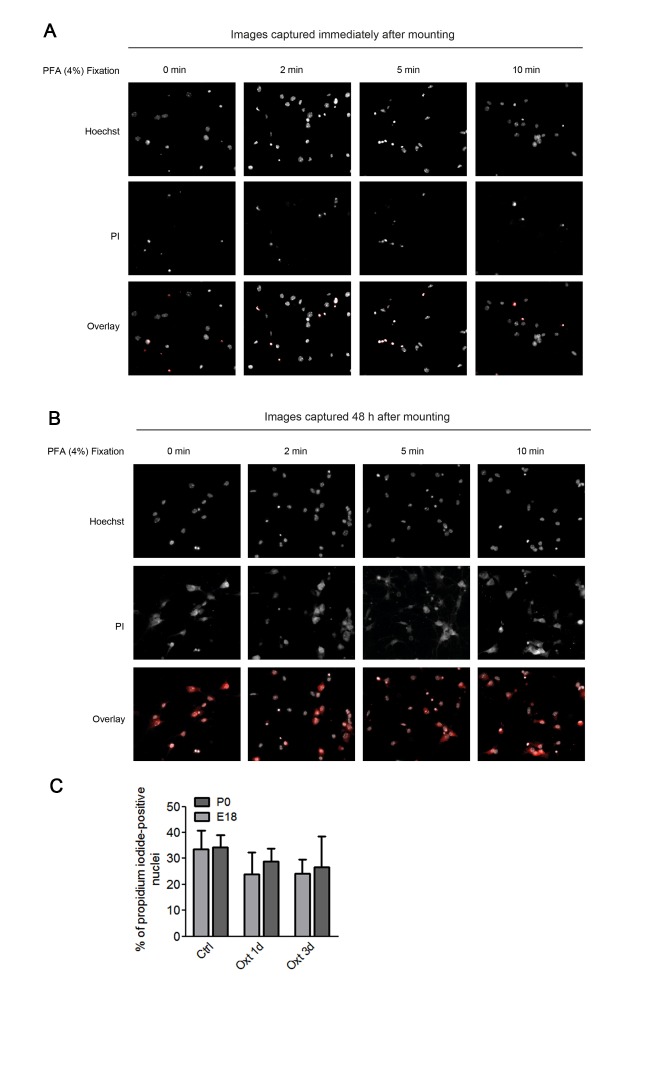
Assessment of apoptosis using propidium iodide.(A) Representative images of propidium iodide (PI)-positive nuclei and Hoechst-labeled nuclei captured immediately after mounting after fixation under different conditions. (B) Representative images of propidium iodide (PI)-positive nuclei and Hoechst-labeled nuclei captured 48 hr after mounting after fixation under different conditions. (C) PI-positive neurons were quantified in separate channels and expressed as a percentage of total cells assessed by Hoechst staining in the same field. Data are expressed as mean ± SD.